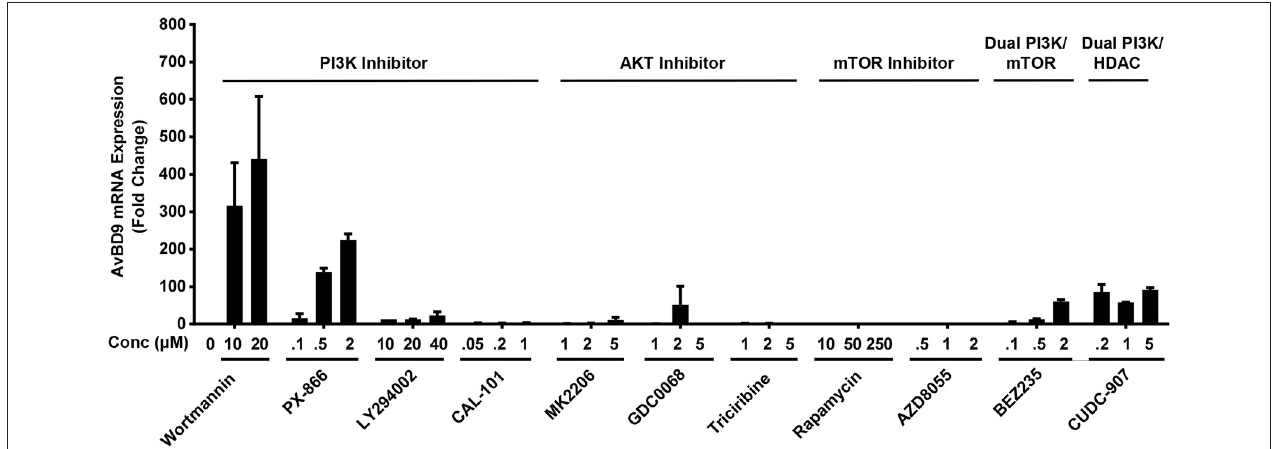
FIGURE 10 | Involvement of the PI3K/AKT/mTOR signaling pathway in AvBD9 mRNA induction. Chicken HTC cells were treated with or without different concentrations of specific inhibitors to PI3K (Wortmannin, PX-866, LY294002, and CAL-101), AKT (MK2206, GDC0068, triciribine) or mTOR (Rapamycin, AZD8055), dual PI3K/mTOR inhibitor (BEZ235) or dual PI3K/HDAC inhibitor (CUDC-907) for 24h, followed by RT-qPCR analysis of AvBD9 gene expression. The results are means ± SEM of 2–3 independent